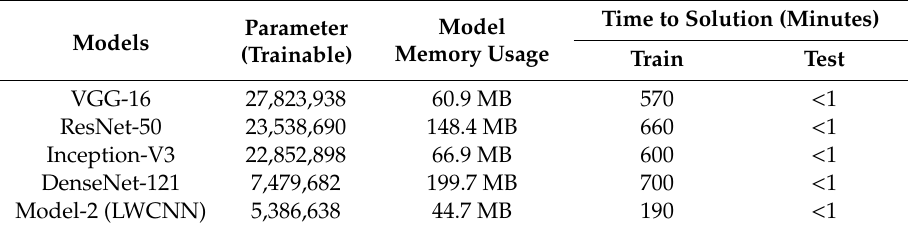
Table 7. Comparing performance and computation cost of model-2 with other pre-trained